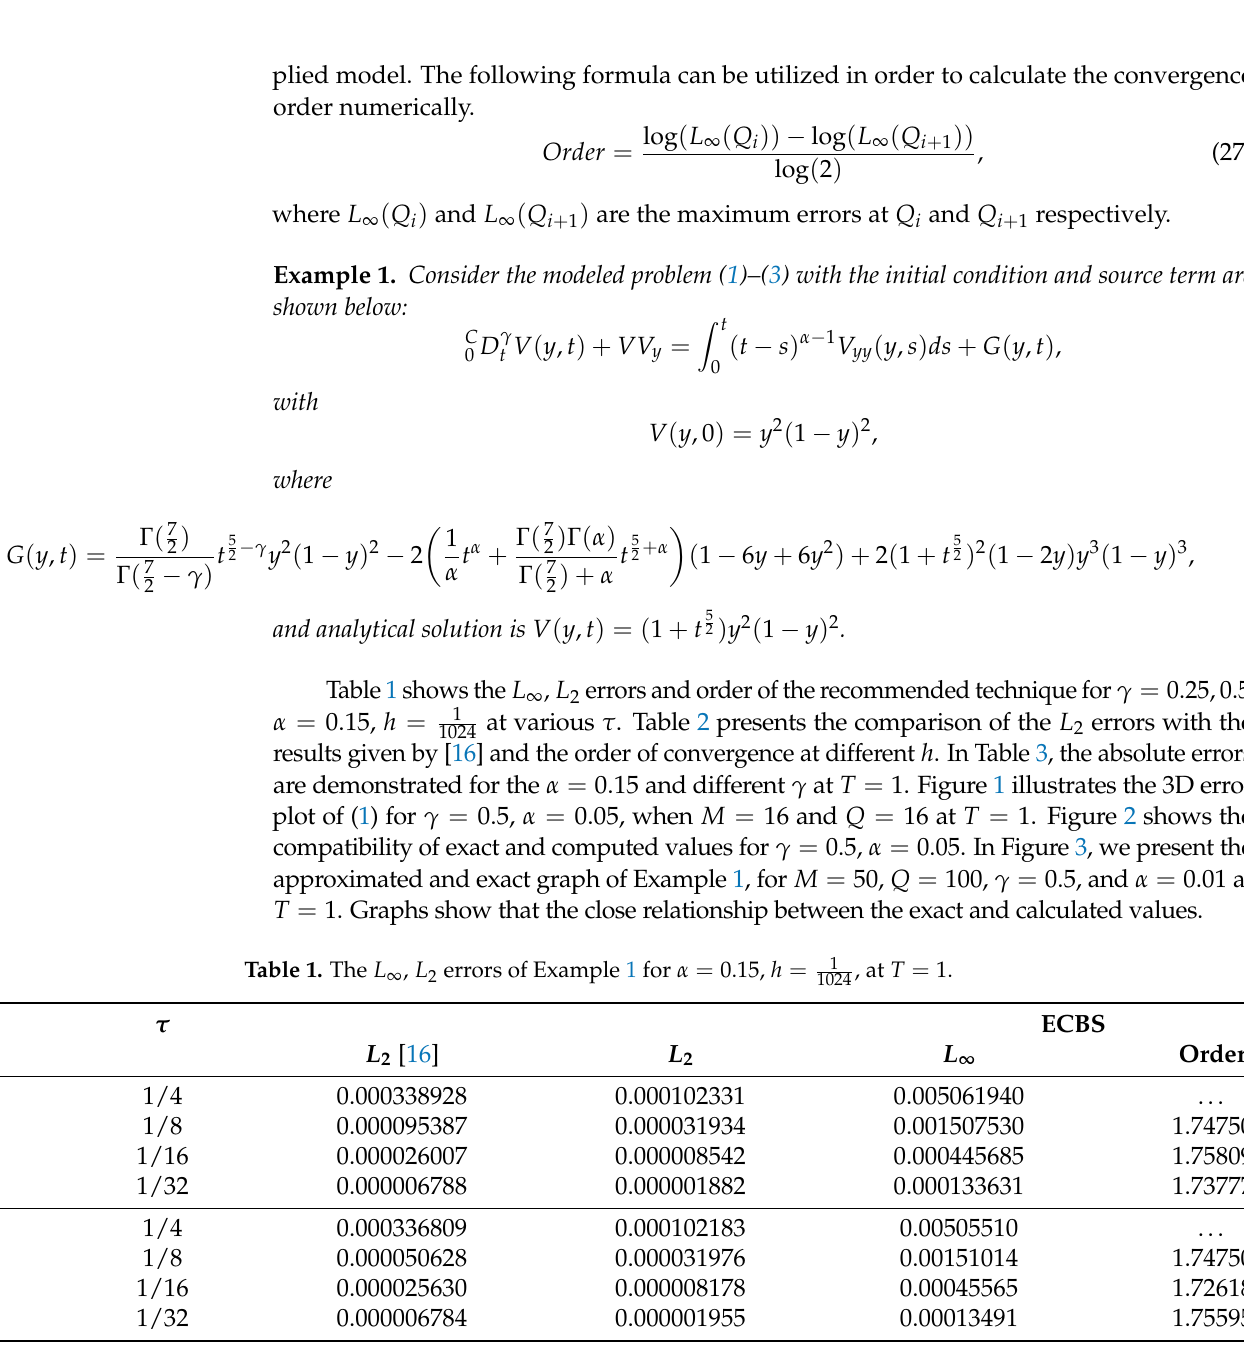
Table 2. The L ∞ , L 2 errors of Example 1 for α = 0.15, τ = 1